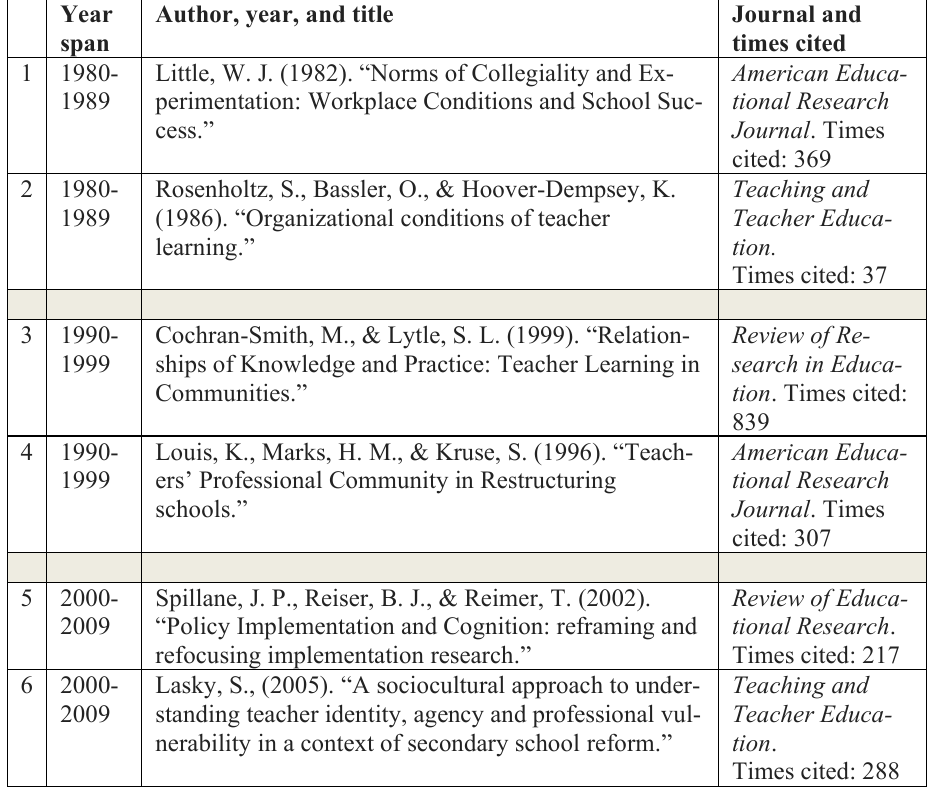
Figure 1. Mean number of articles on teacher and collegiality and professionalism in this paper’s selected journals After an increase also in the early 2000s, the interest in teacher collegiality has re- mained relatively stable in these journals. The two most frequently cited articles within each year span used in this analysis are presented in Table 1. Table 1a Articles chosen for the